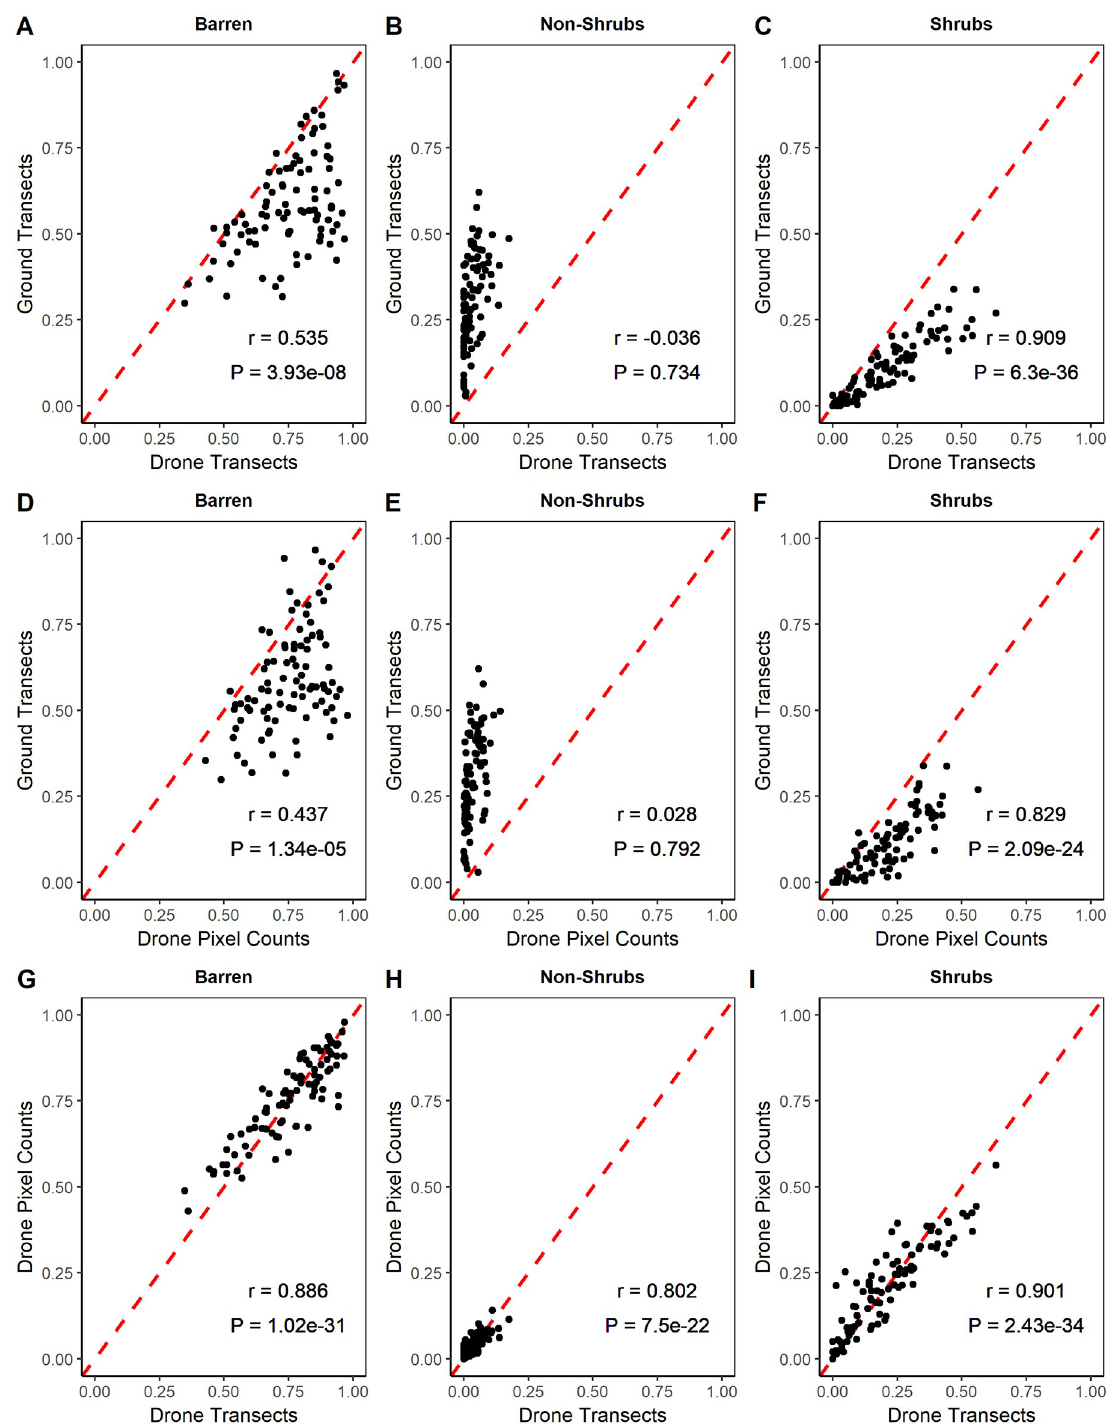
Fig 3. Plotted proportional values and Pearson’s correlation coefficients between three methods of data acquisition (ground transects, drone transects and drone pixel counts). Data presented for each cover type (barren, non-shrubs, and shrubs). Each point represents proportional cover data collected within the same cell (n = 92) for each method. Drone imagery collected at 75 m AGL. Red dashed line represents 1:1 relationship.